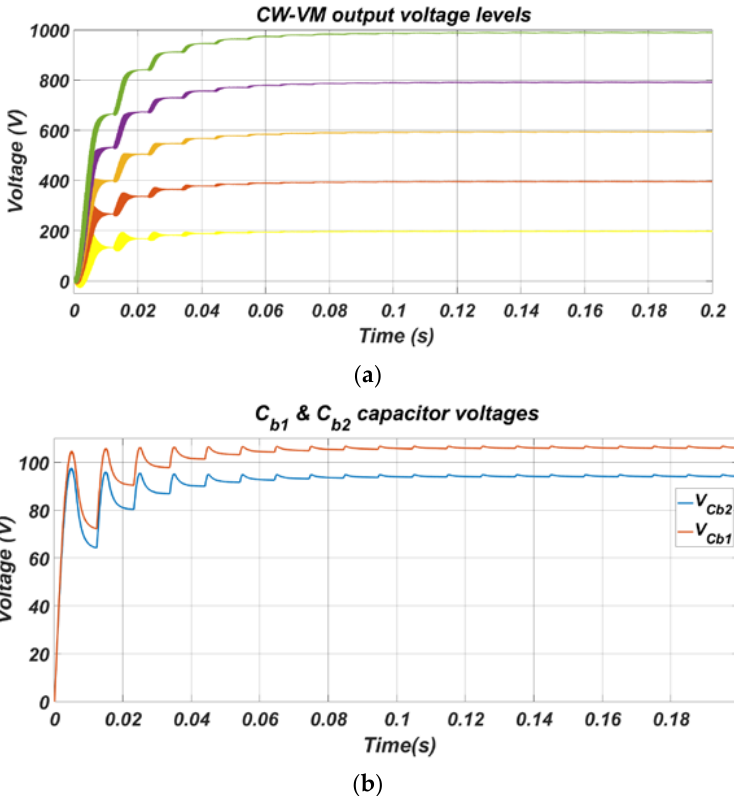
Figure 6. Key waveforms of the AC/DC converter: ( a ) CW-VM output voltage levels; and ( b ) DC bus capacitors voltages.